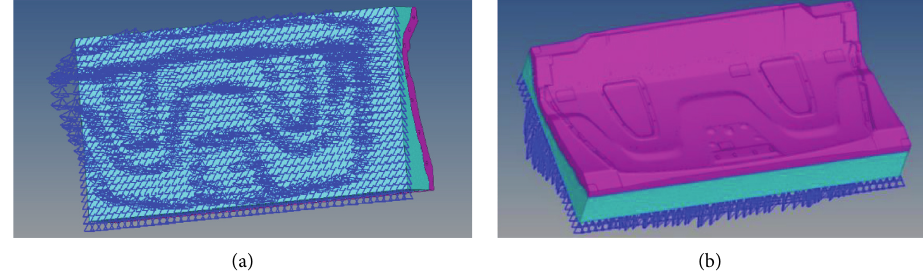
Figure 10: Boundary condition diagram of the upper die definition. (a) The upper die defines the boundary conditions. (b) The upper die defines the boundary